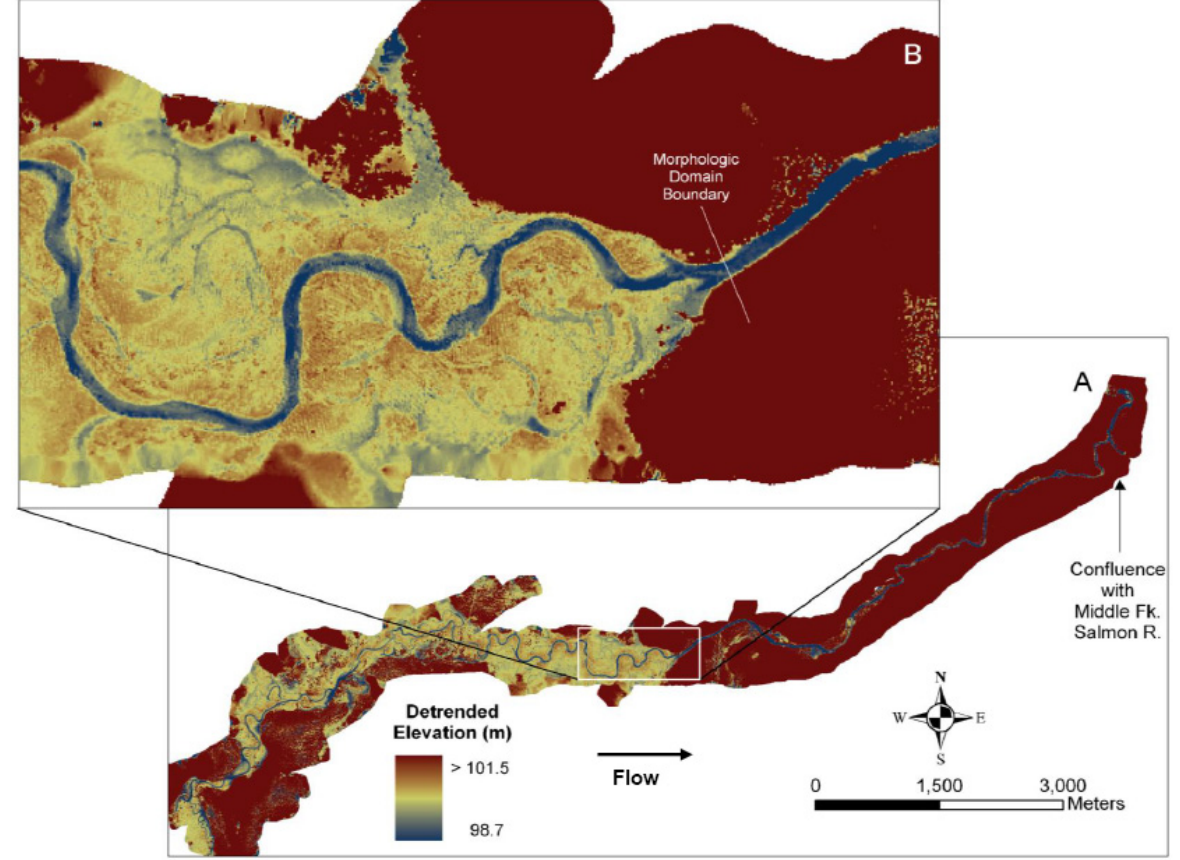
Figure 10 . (A) Detrended DEM of lower Bear Valley Creek, Idaho, USA. The solid field of high elevations in the downstream half of the image is mountains adjacent to the channel which is flowing in a deep canyon through this area; (B) Detailed view of a portion of the detrended DEM. Elevations are relative to an arbitrary datum set during